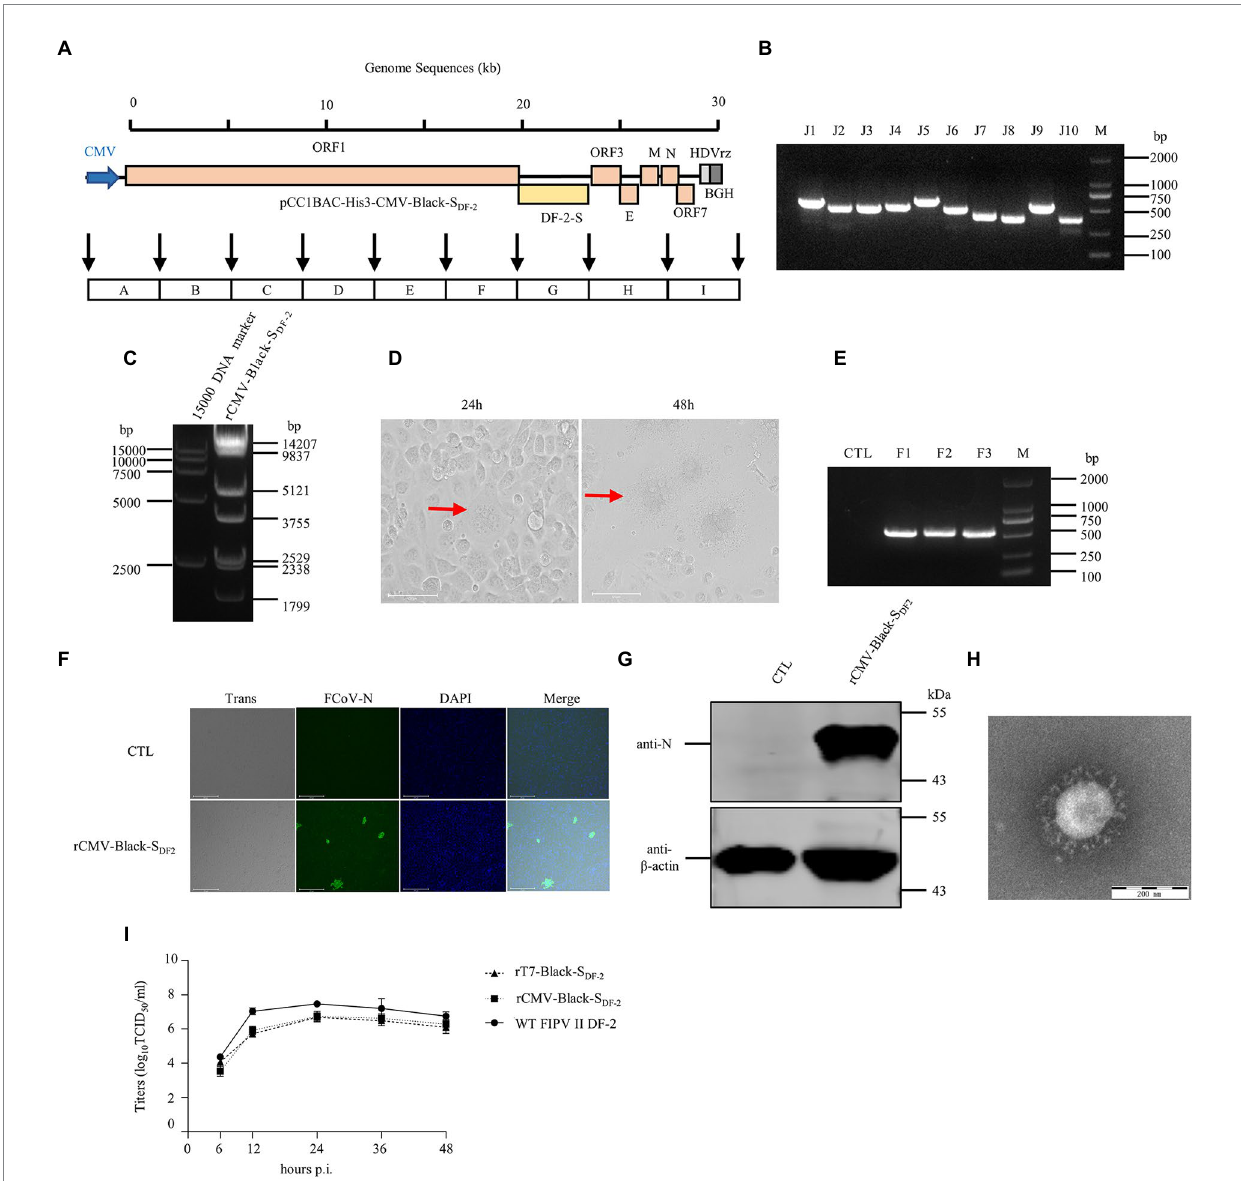
FIGURE 3 The recovery and identification of the chimeric FIPV strain Black-S DF-2 driven by a CMV promoter. (A) Strategy diagram for the construction of pCC1BAC-His3-CMV-Black-S DF-2 . (B) Identification of fragment interfaces in bacteria. (C) Enzyme digestion of pCC1BAC-His3-CMV-Black-S DF-2 plasmid ( Not I and Nhe I). (D) Significant cytopathic effects (CPE) were observed at 24 and 48 h after infection with CRFK cells. (E) PCR identification of the recombinant virus. (F) and (G) rCMV-Black-S DF-2 virus infected CRFK cells for 12 h was identified by IFA (Scale Bar, 275 μ m) and WB. (H) Electron microscopy examination of the purified virus. (I) Growth kinetics of rT7-Black-S DF-2 , rCMV-Black-S DF-2 , and WT FIPV II DF-2 after infection of CRFK cells at an MOI of 0.01. wt, wild